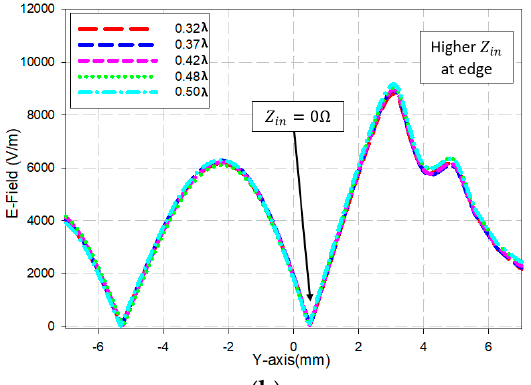
Figure 7. Proposed antenna with C-shaped parasitic structure.